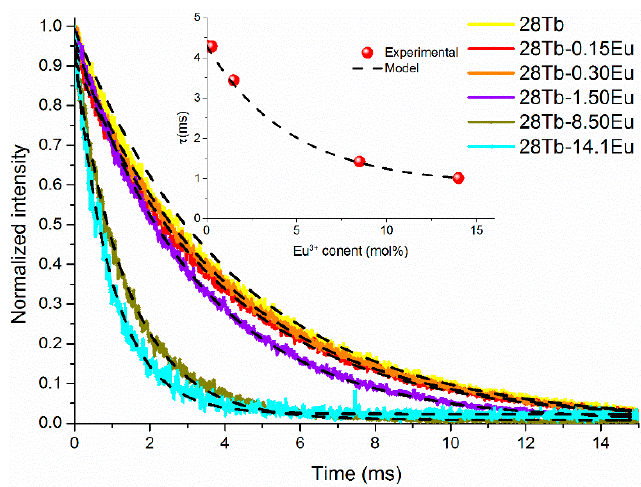
Figure 7. Experimental lifetime curves. The inset is a graph of experimental lifetime. Black lines represent the fitting model.